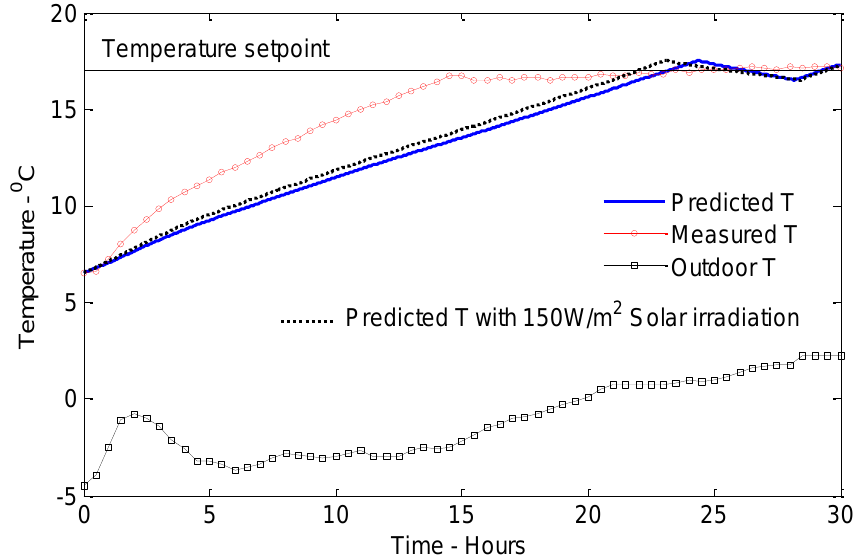
Figure 9. Variation of the internal and external air temperatures for Case 4. The effect of the change in solar irradiation is also